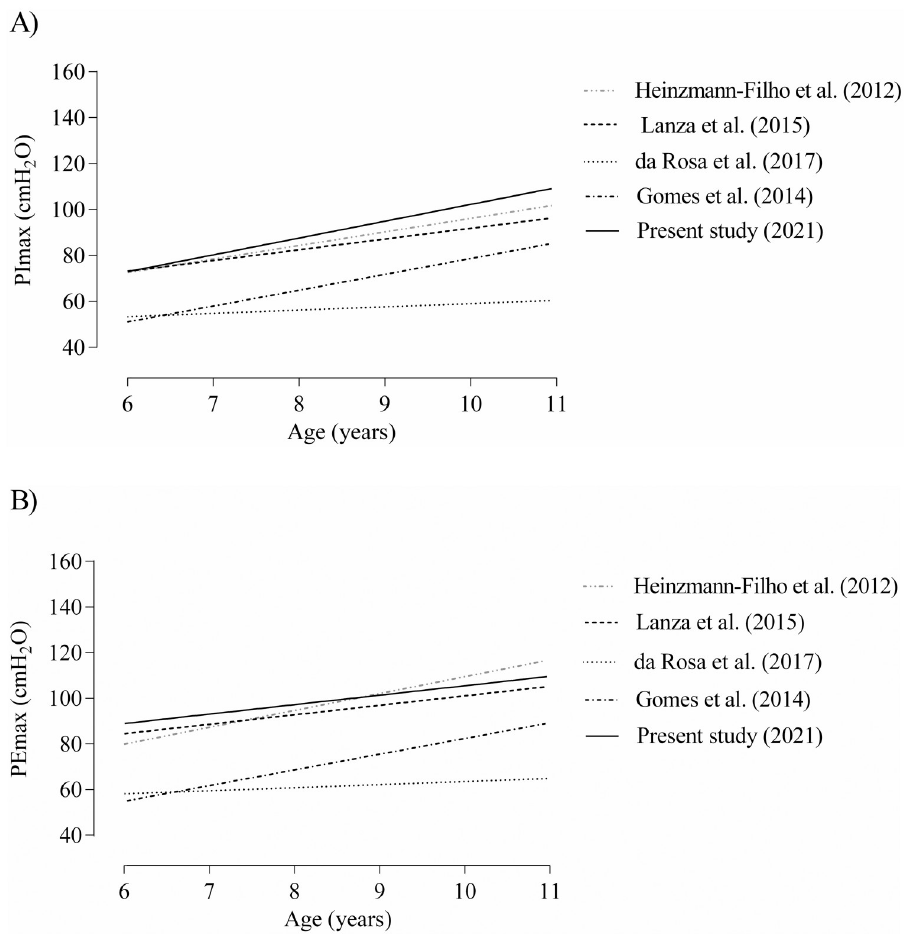
Fig 3. Trend lines of predicted values for PImax (A) and PEmax (B) observed in the present study and in previous Brazilian studies, according to age groups.